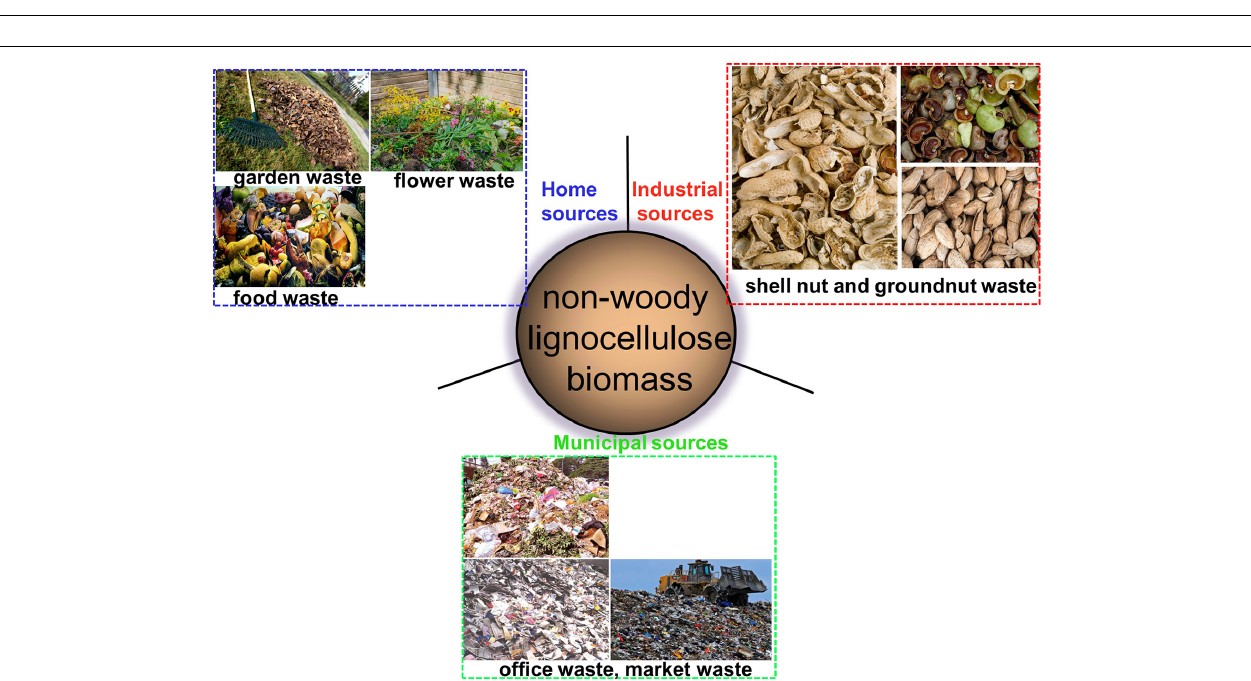
FIGURE 1 | A schematic showing the transition of plant fibers to cellulose nanoparticles.